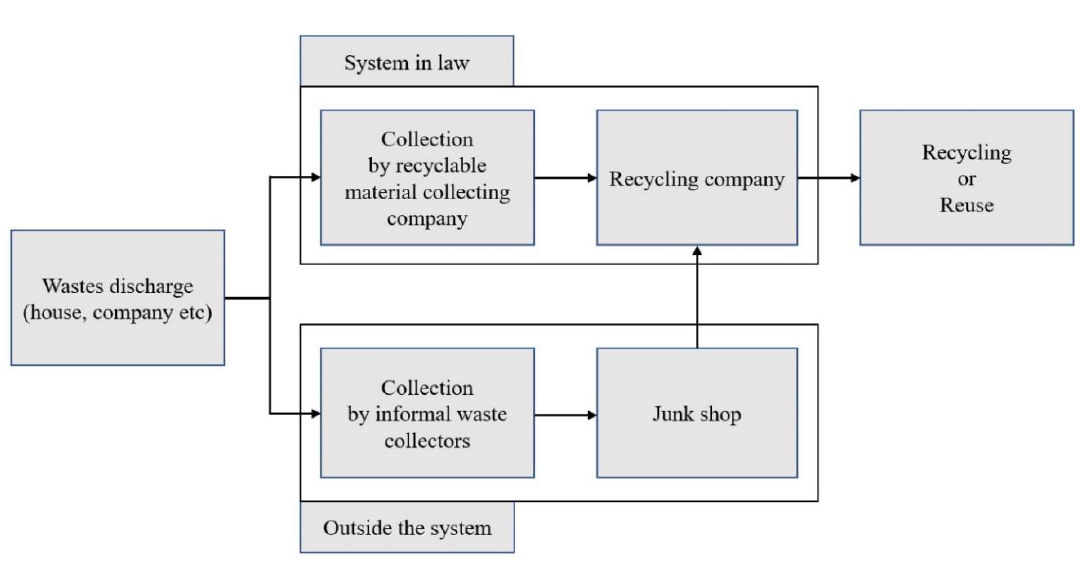
Figure 1. Recycling process in Korea and the role of informal waste collectors.